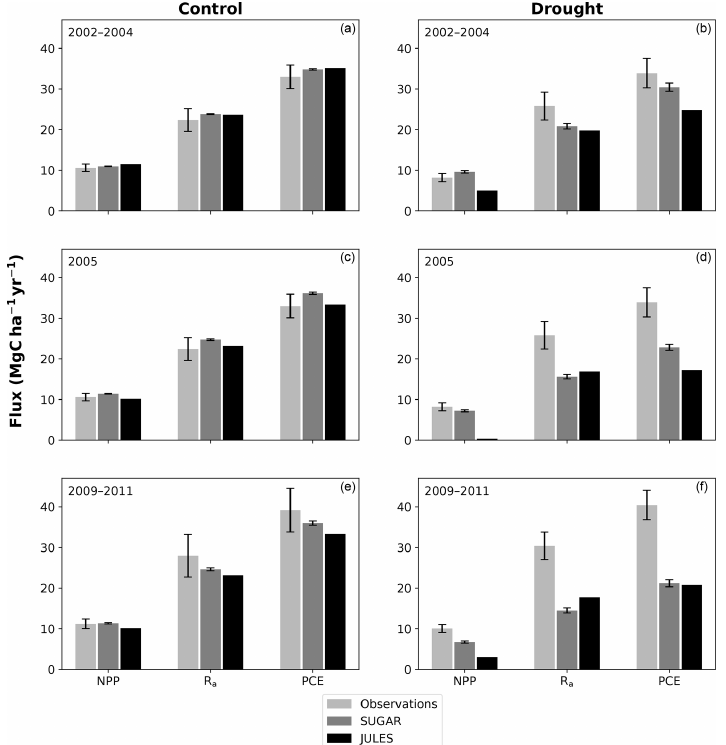
Figure A6. Net primary productivity (NPP), autotrophic respiration ( R p ) and plant carbon expenditure (PCE = NPP + R p ) for the periods 2002–2004, 2005 and 2009–2011. Panels (a) , (c) and (e) are from the control plot and (b) , (d) and (f) are from the throughfall exclusion (TFE) plot. Soil moisture stress has been artificially reduced in JULES by 50%, and the resulting GPP has been used to drive SUGAR. Model predictions from JULES and SUGAR are calculated by taking the mean of each flux over each period. Observations for 2005 are from Metcalfe et al. (2010), and observations from 2009–2011 are from da Costa et al. (2014). Simulated photosynthesis in JULES responded almost instantly to the introduction of the panels on the TFE plot, which meant that NPP, R p and PCE changed significantly in both models between 2002 and 2005. To demonstrate this change we show predicted fluxes during the 2002–2004 period and from 2005. Observations for this period are not available to such a comprehensive degree as they are for 2005 and the 2009–2011 period. For this reason we compare the model predictions for 2002–2004 to the 2005 observations. This is reasonable in the control plot, where it is plausible that the forest was in steady state (Metcalfe et al., 2010), and thus fluxes from 2005 will be similar to those during the 2002–2004 period. In the TFE plot, while there were some significant changes in observed carbon fluxes during the first 3 years of the experiment (for example the production of leaves, flowers and fruits, and fine wood Rowland et al., 2018; Meir et al., 2018), the forest largely resisted the effects of the drought during this period (significant increases in mortality were not seen until 2005 Rowland et al., 2015; Meir et al., 2018), and thus we can similarly expect fluxes from 2002–2004 to be comparable to those from 2005. Nonetheless, care should be taken with these comparisons in both